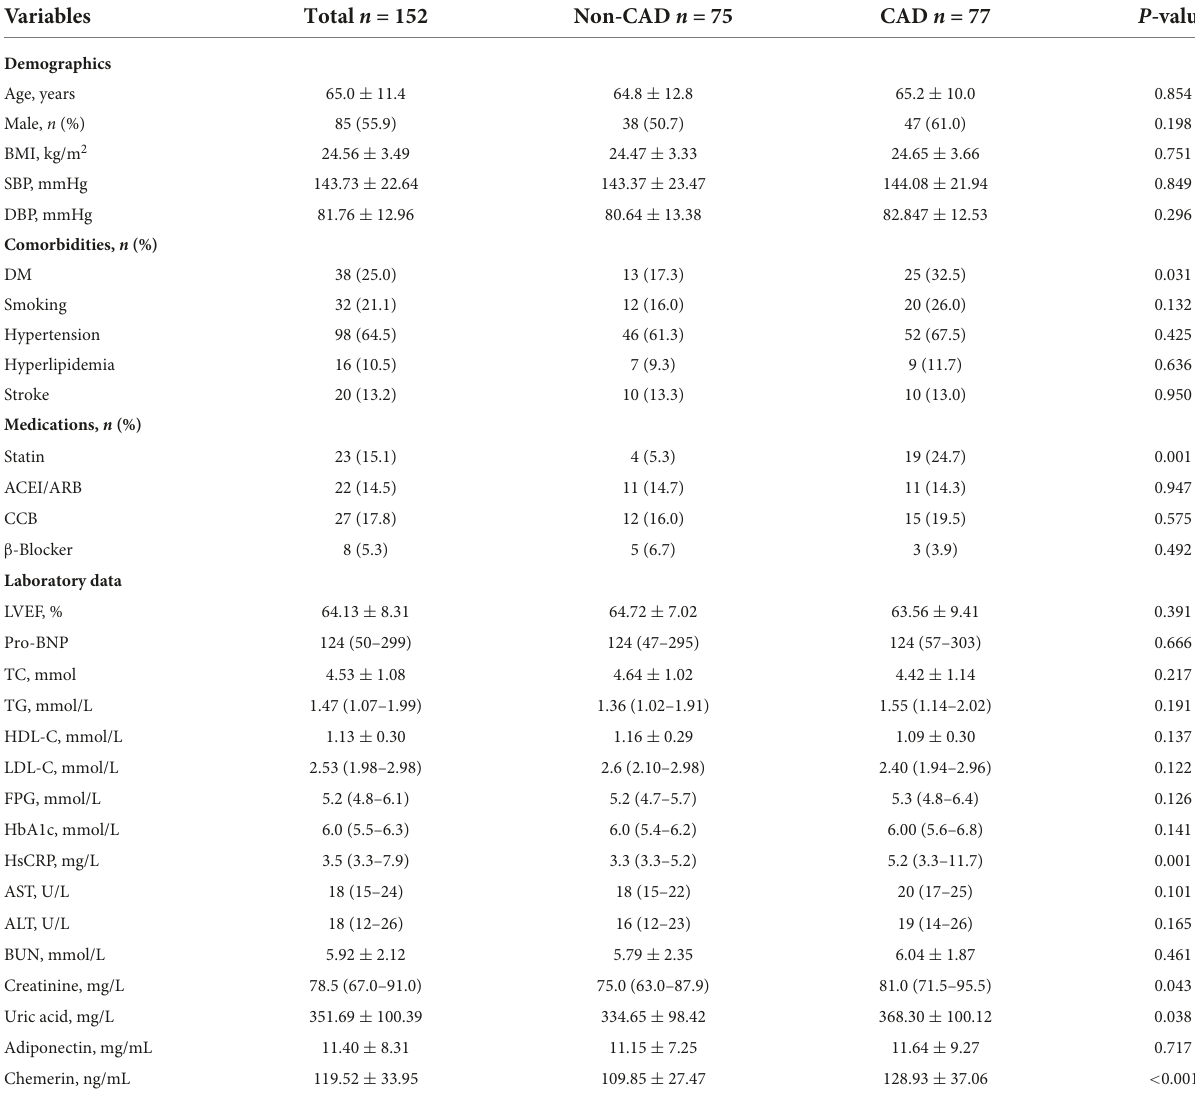
TABLE 1 Baseline characteristics in CAD/non-CAD groups.